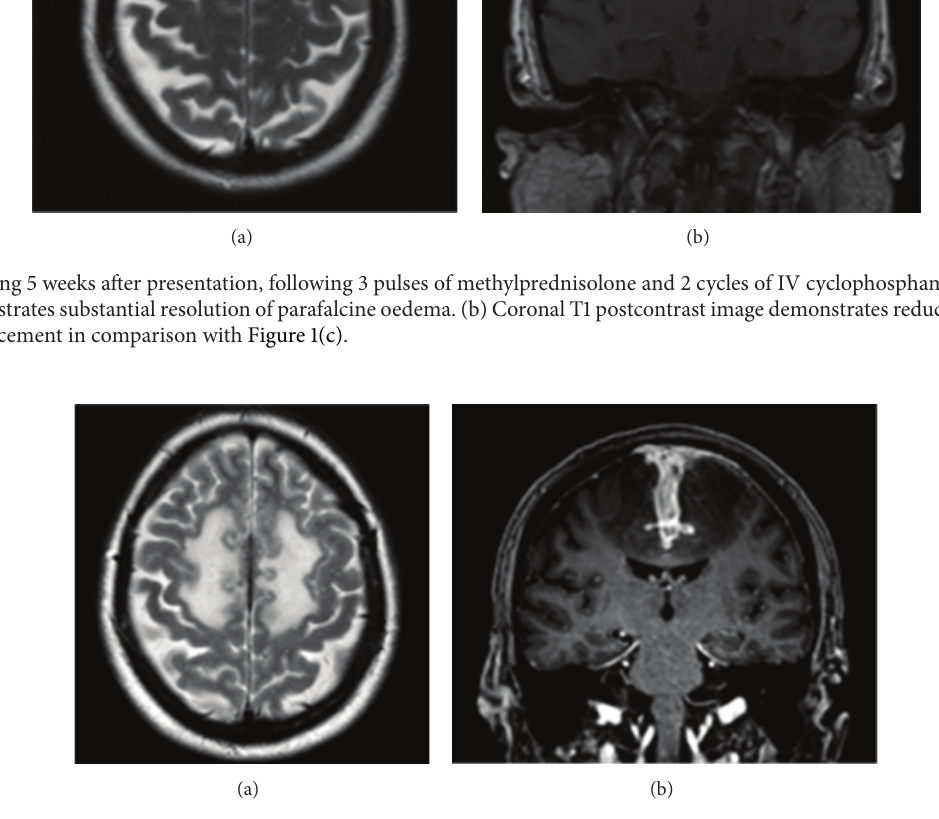
(peak value 23.5 × 10 9 /L), and neutrophils 10.7 × 10 9 /L (peak value 20.7 × 10 9 /L); haemoglobin remained in the normal